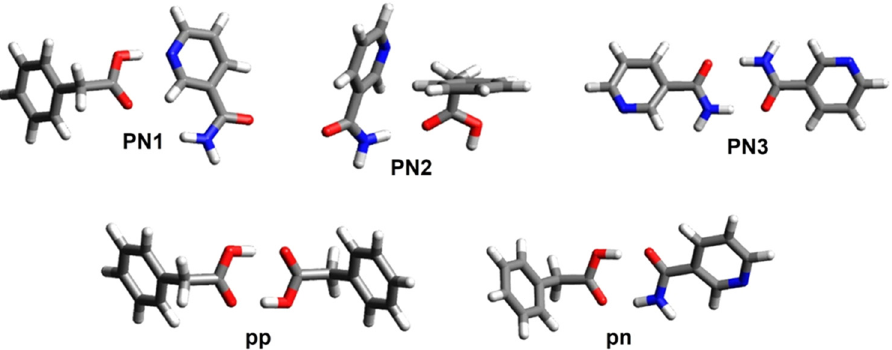
Figure 1: Main conformation of PYCNIC cocrystal. Molecular dimers are denoted by P ( PYC ) and N ( NIC ) . Capital letters represent the existing cocrystal conformation, while lowercase letters represent the putative